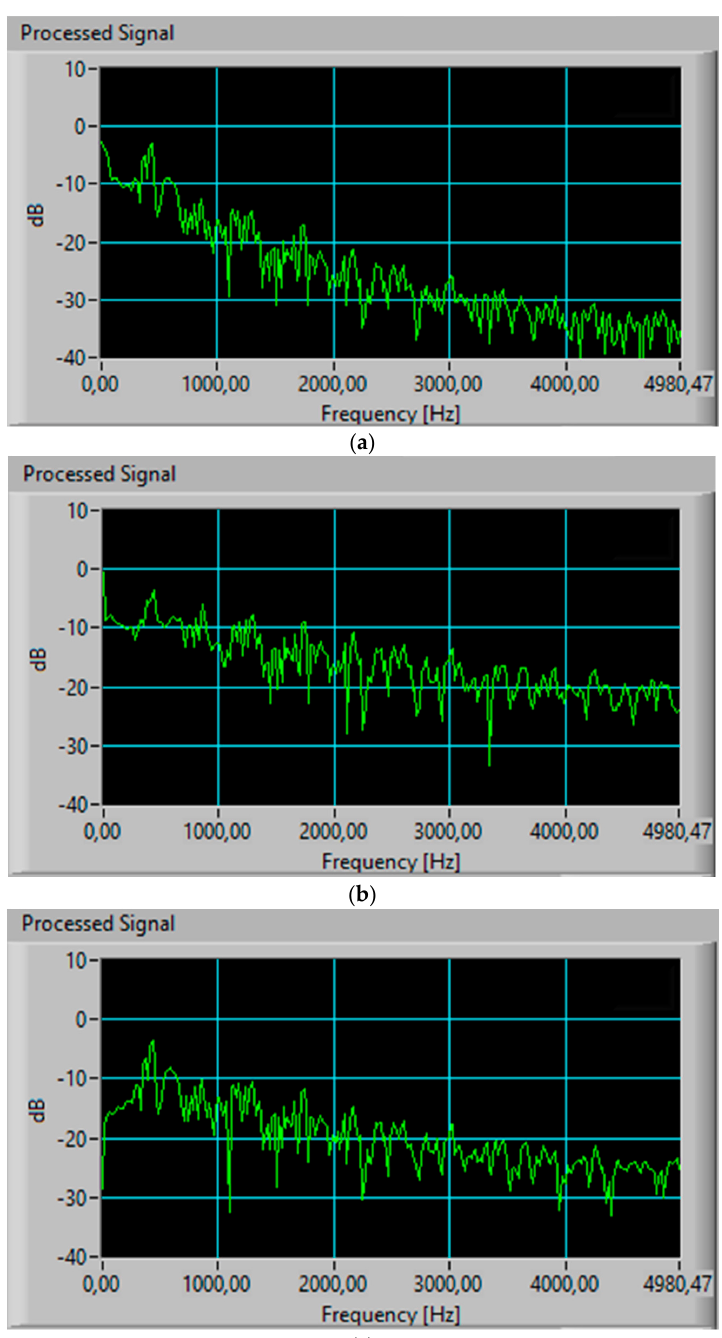
Figure 8. The spectral distribution of the new chaotic system: ( a ) X-signal, ( b ) Y-signal and ( c ) Z-signal.